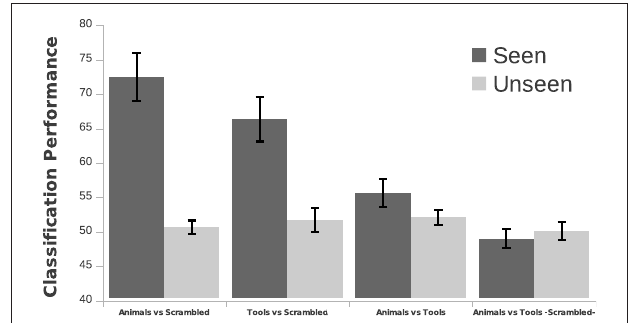
FiGurE 7 | Single trial classification performance. Multivariate pattern analysis was used to discriminate between experimental conditions. The classifier was well above chance level for the discrimination of seen animals and seen tools against their scrambled controls ( p < 0.0001). Also, the classifier found suggestive evidence of a discrimination between seen animals and seen tools categories but the final classification performance was not significant at the confidence level of 0.01 that we adopted in this work ( p = 0.0518). The classifier was at chance level at discriminating scrambled animals from scrambled tools ( p > 0.05). Seen animals versus seen tools was higher than the discrimination of seen scrambled animals versus seen scrambled tools ( p < 0.01). This implies that low-level image statistics cannot account for the decoding of animals versus tools. For all the unseen stimuli comparisons the classification performance was at chance level. The classifier was run on each subject separately and the final classification performance was obtained from the average across subjects. Error bars depict one